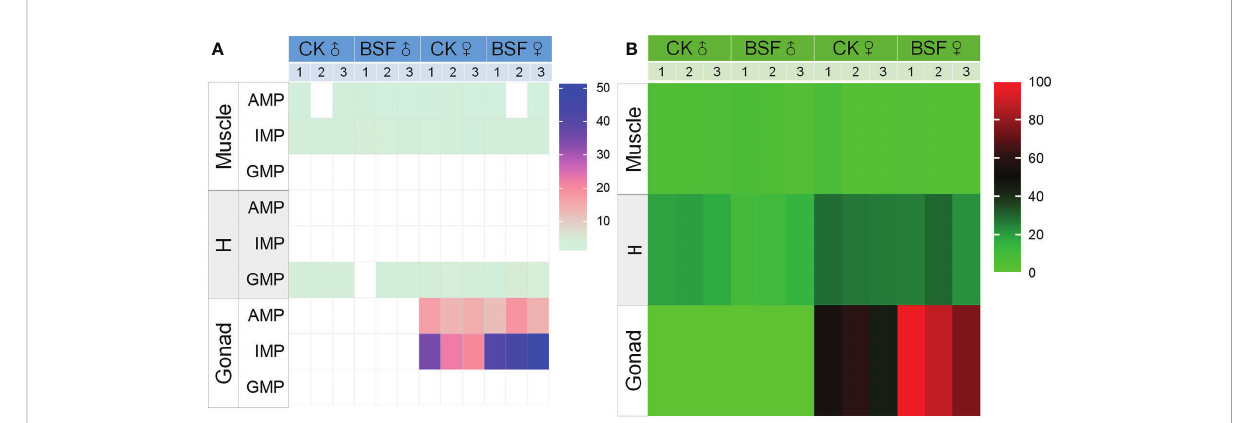
FIGURE 5 Effects of BSFL feeding on umami evaluation indices in edible tissues of mitten crabs. (A) TAVs of nucleotides. White boxes indicate that TAV< 1.0. (B) EUC heatmap showing the effects of various umami amino acids and nucleotides on umami fl avor. CK, control group; BSF, experimental group; ♂ , female crabs; ♀ , male crabs. n =